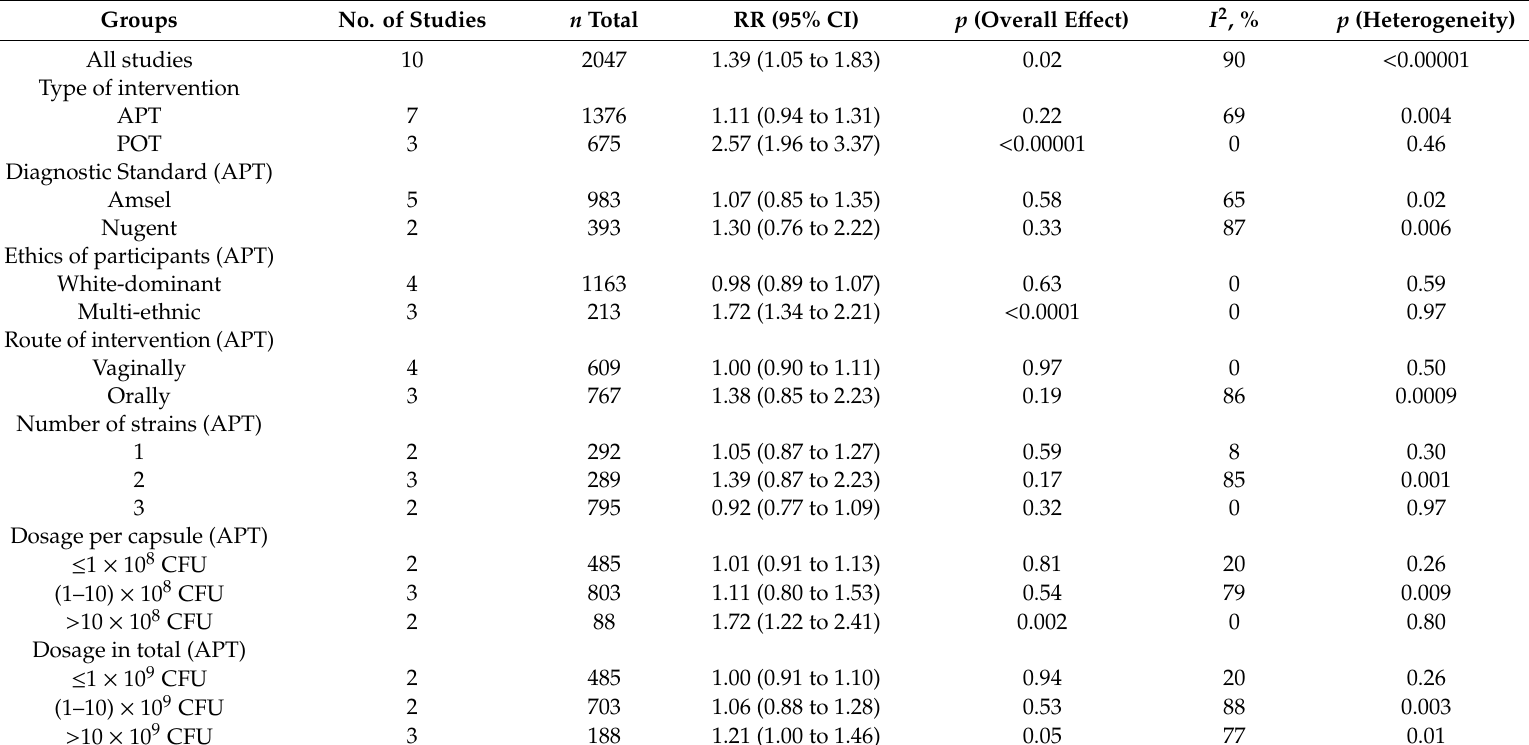
Table 1. Summary of subgroup analysis